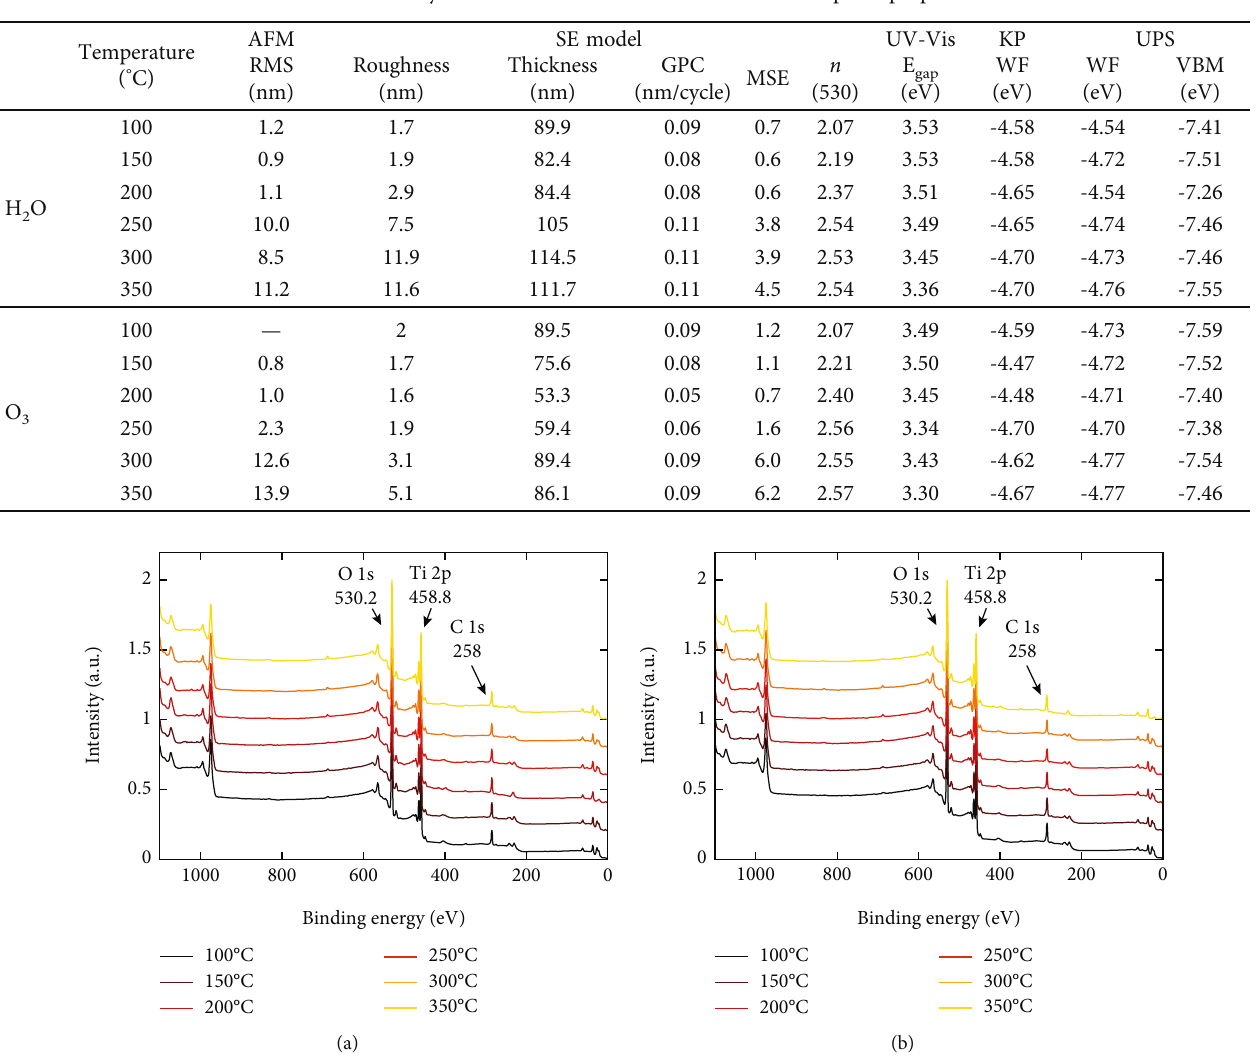
with (a) H O and (b) O as reactant at varying deposition temperatures and 1000 deposition 2 2 3